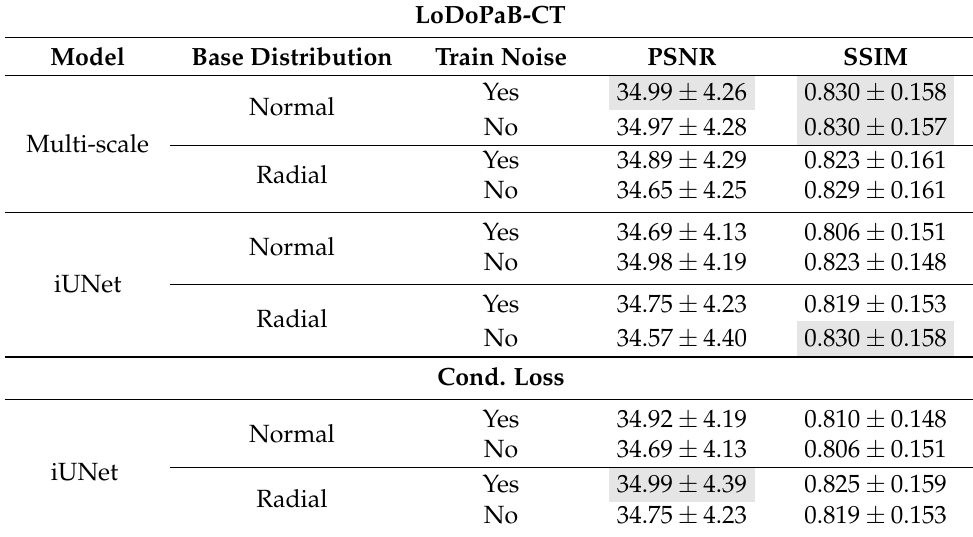
Table A1. Mean and standard deviation of the PSNR and SSIM for the LoDoPaB-CT test set. Condi- tioned mean computed with 1000 samples. Unless stated otherwise, training noise was applied and no cond. loss was